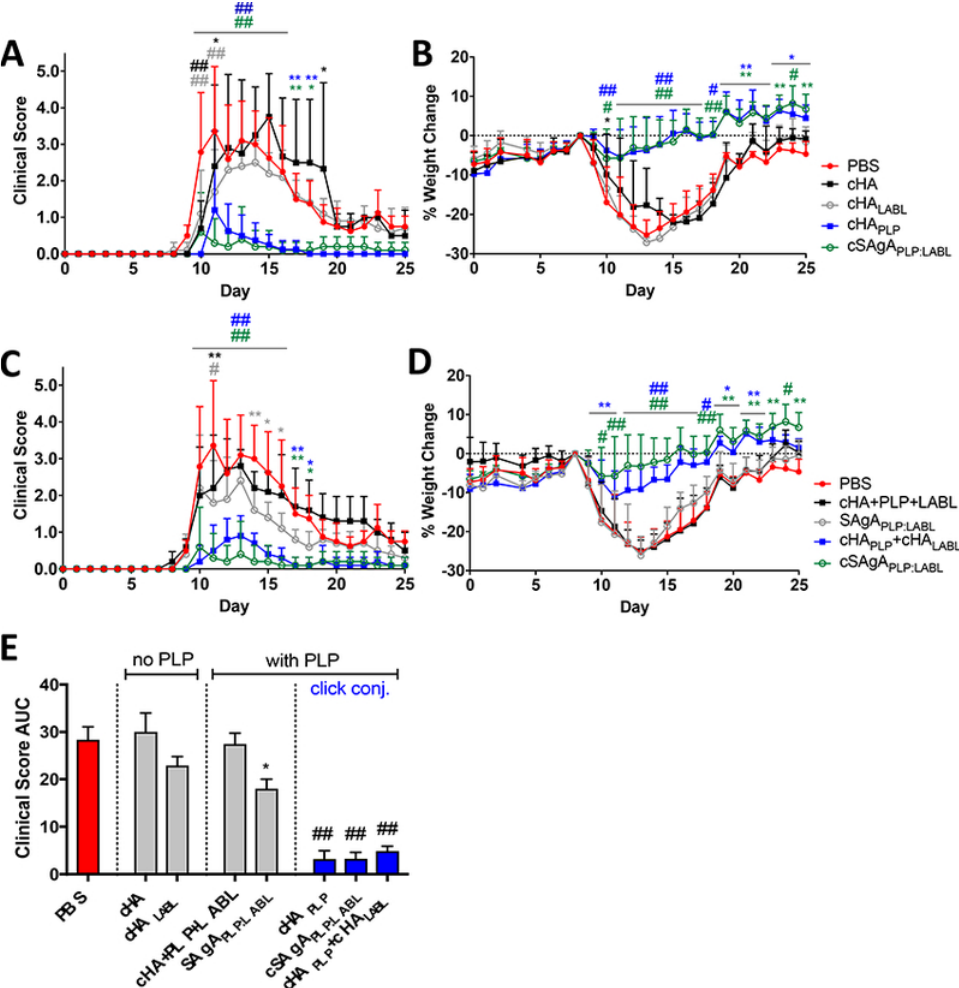
Figure 11. EAE in vivo response to click conjugates (cHA, cHALabl, cHAPLP, and cSAgAPLP:LABL) as measured by ( A ) clinical disease score and ( B ) percent weight loss. EAE in vivo response to groups containing both PLP and LABL (cHA+PLP+LABL, SAgAPLP:LABL, cHAPLP+cHALABL, and cSAgAPLP:LABL) as measured by ( C ) clinical disease score and ( D ) percent weight loss. Data represent mean ± SD ( n = 5); statistical significance compared to PBS negative control was determined by two-way ANOVA. ( E ) Cumulative EAE in vivo response as measured by clinical disease score area under the curve (AUC) derived from subfigures A and C. Data represent mean ± SEM ( n = 5); statistical significance compared to PBS negative control was determined by ordinary one-way ANOVA followed by Dunnett’s post hoc test. (* p < 0.05, ** p < 0.01, # p < 0.001, ## p < 0.0001, color coded according to group) (with permission of [185]).